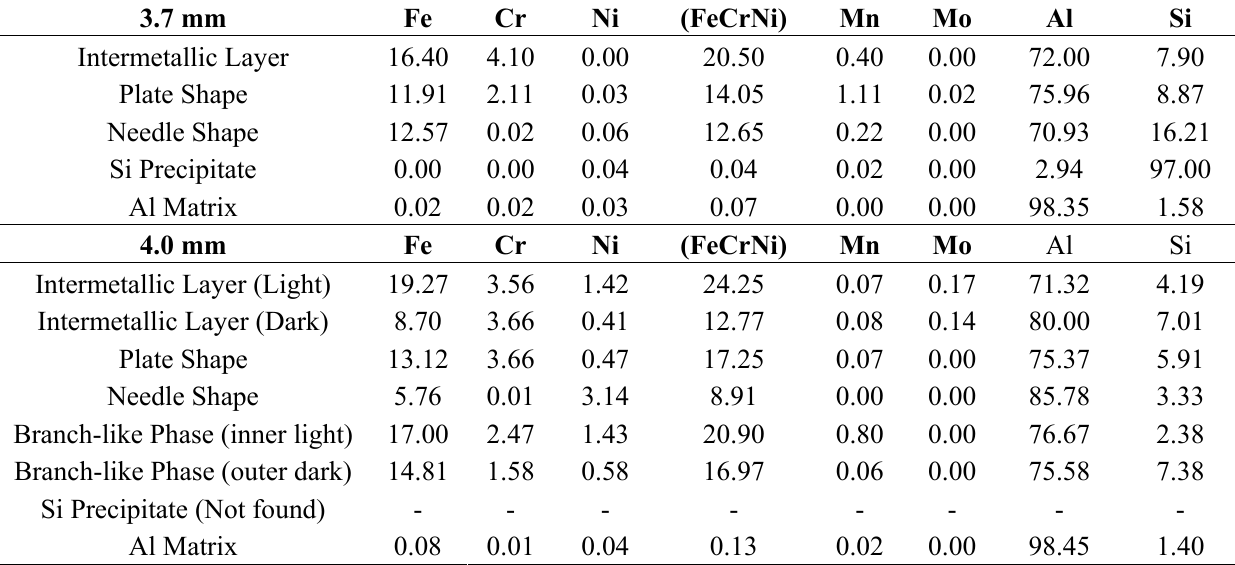
Table 4. EDS results showing the composition of intermetallic phases and Al matrix (in atomic %) for both Al-S CMFs made with 3.7 and 4.0 mm